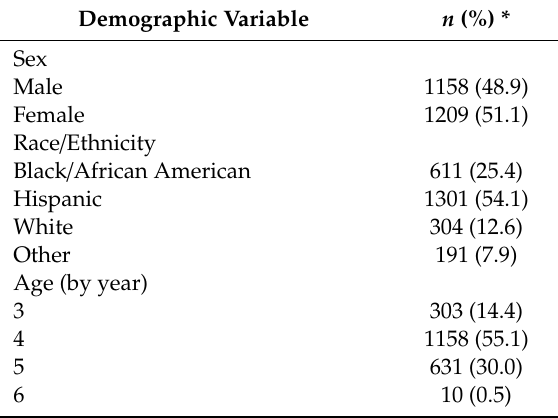
Table 4. Population Characteristics, SCALE-UP Study, All 4 Kids © ( n =